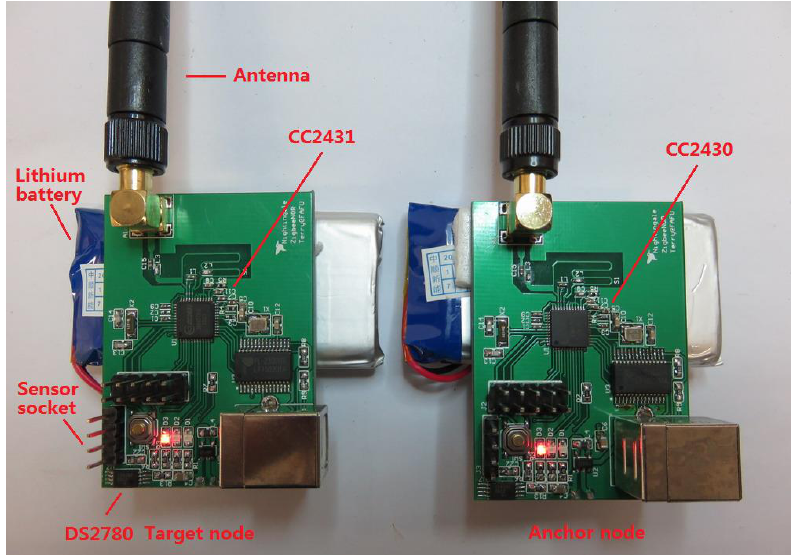
Figure 12. Illustration of the anchor node and target node. Sensors 2016 , 16 , 788